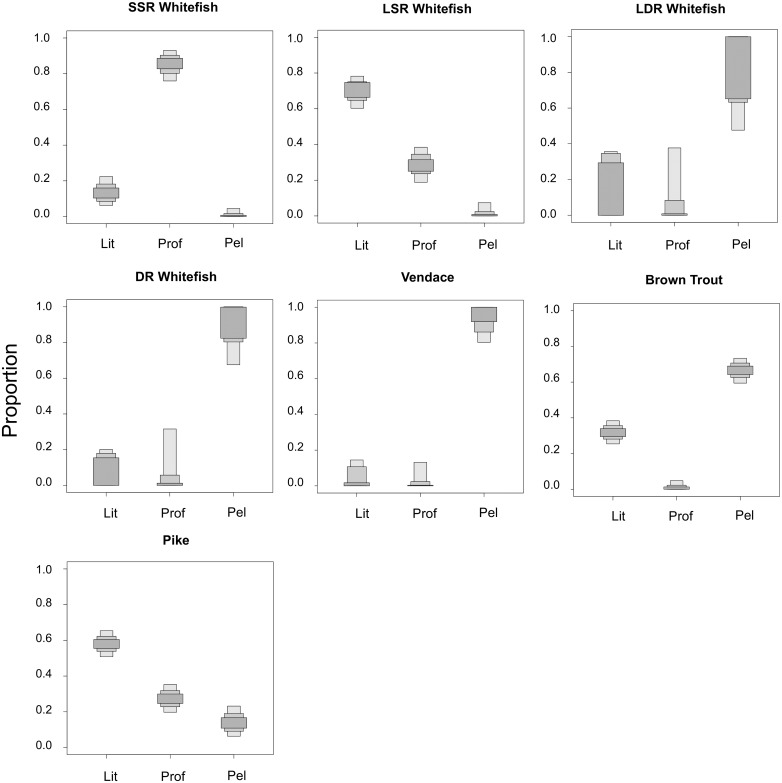
Credibility plots of proportional use of littoral (Lit), profundal (Prof) and pelagic (Pel) resources by seven fish species in lakes of the Paatsjoki watercourse, based on estimates by the Stable Isotope Analysis in R (SIAR) package.Bars represent 95%, 75% and 50% credibility intervals around mean estimates derived from 500,000 iterations, with the first 50,000 discarded.